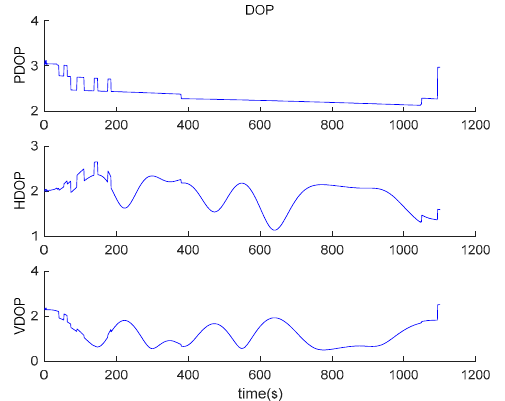
Figure 12. Positional dilution of precision of satellites.